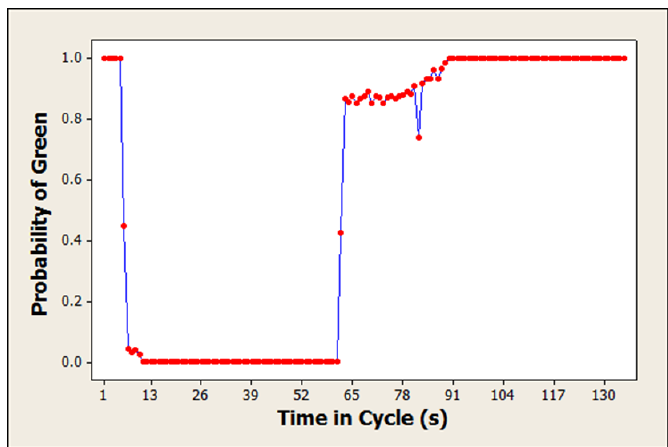
Figure 3. Probability of Green Time.